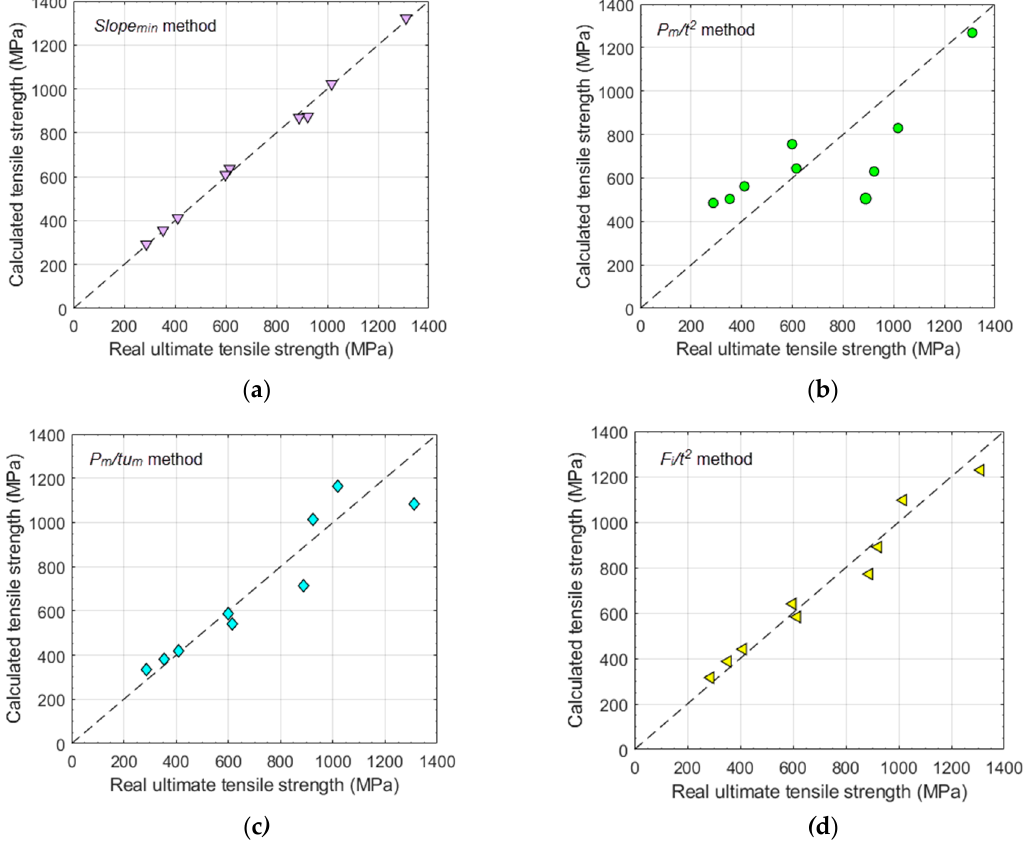
Figure 16. Calculated vs. real ultimate tensile strength of the experimental tests: ( a ) Slope min method, ( b ) P m / t 2 method ( c ) P m / tu m method ( d ) F i / t 2 method.